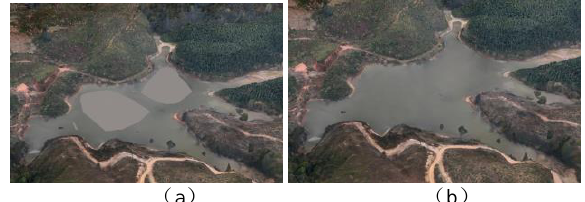
Figure 13 ． The effect of the restoration of the holes in water (a) before, (b) after.